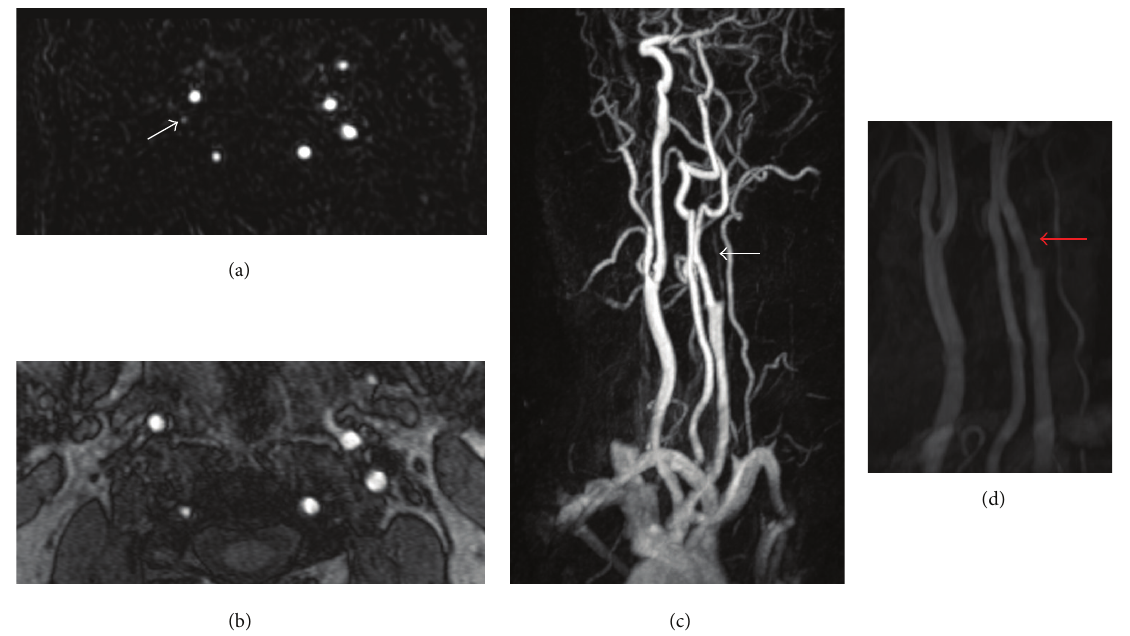
Figure 1: Forty-nine-year-old male patient with high-grade asymptomatic stenosis of the right external carotid artery detected with ultrasonography. While a filiform stenosis is seen on the contrast enhanced images (white arrow), the lumen of the right internal carotid artery is not seen on TOF images and the finding was interpreted as occlusion (red arrow). (a) Axial reformat of the subtracted contrast- enhanced MR angiography (CEMRA), (b) maximum intensity projection (MIP) of the CEMRA dataset, (c) axial time-of-flight (TOF) MR angiography image, and (d) MIP of the TOF MRA dataset. The much smaller axial field-of-view of the TOF MRA is clearly seen on the MIP